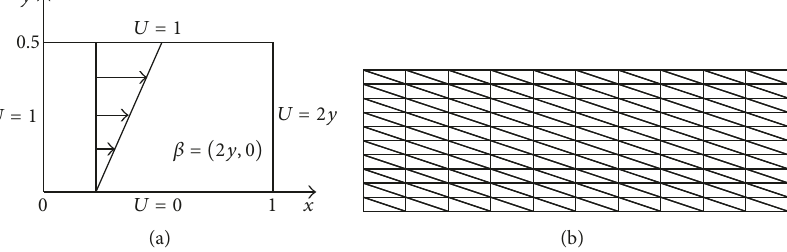
Figure 16: (a) Configuration of Experiment 3. (b) Triangular elements used in the discretization of the problem